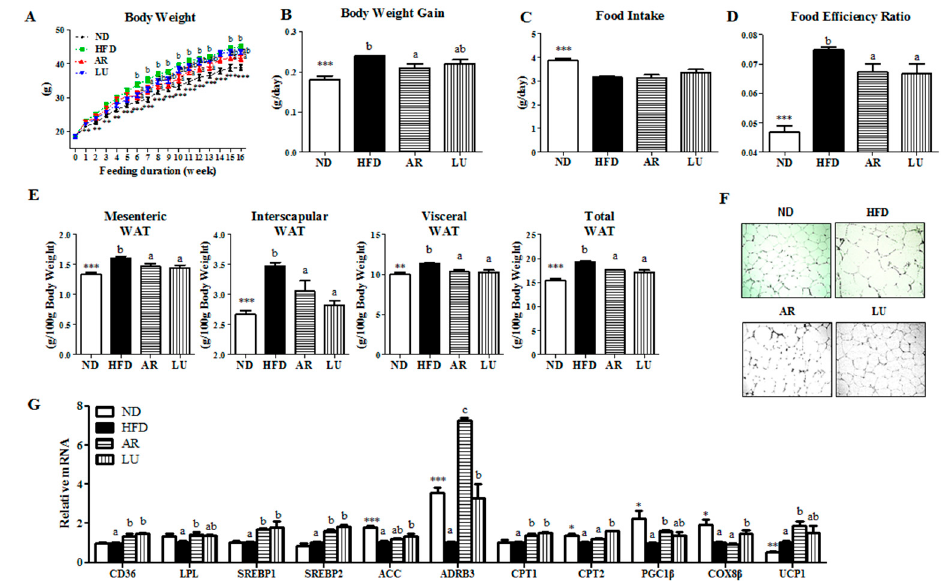
Figure 1. Effects of luteolin-enriched artichoke extract and luteolin on changes in the body weight ( A ), body weight gain per day ( B ), food intake ( C ), food efficiency ratio ( D ), white adipose tissue (WAT) weight ( E ), WAT morphology (magnification 200 × ) ( F ), and WAT gene expression ( G ) in C57BL/6N mice fed a high-fat diet (HFD). Data are the mean ± SEM. Significant differences between the HFD and ND groups are indicated: * p < 0.05, ** p < 0.01, *** p < 0.001. Bars marked with different lower case letters indicate significant differences among the groups based on the HFD (HFD, AR, and LU) at p < 0.05. Bars marked with the same lower case letters indicate no significant differences among the groups based on the HFD. ND, normal diet (AIN-76), HFD, high-fat diet (20% fat, 1% cholesterol), AR, HFD + 0.005% luteolin-enriched artichoke, LU, HFD + 0.005% luteolin. The food efficiency ratio is given as the body weight gain per food intake per day.